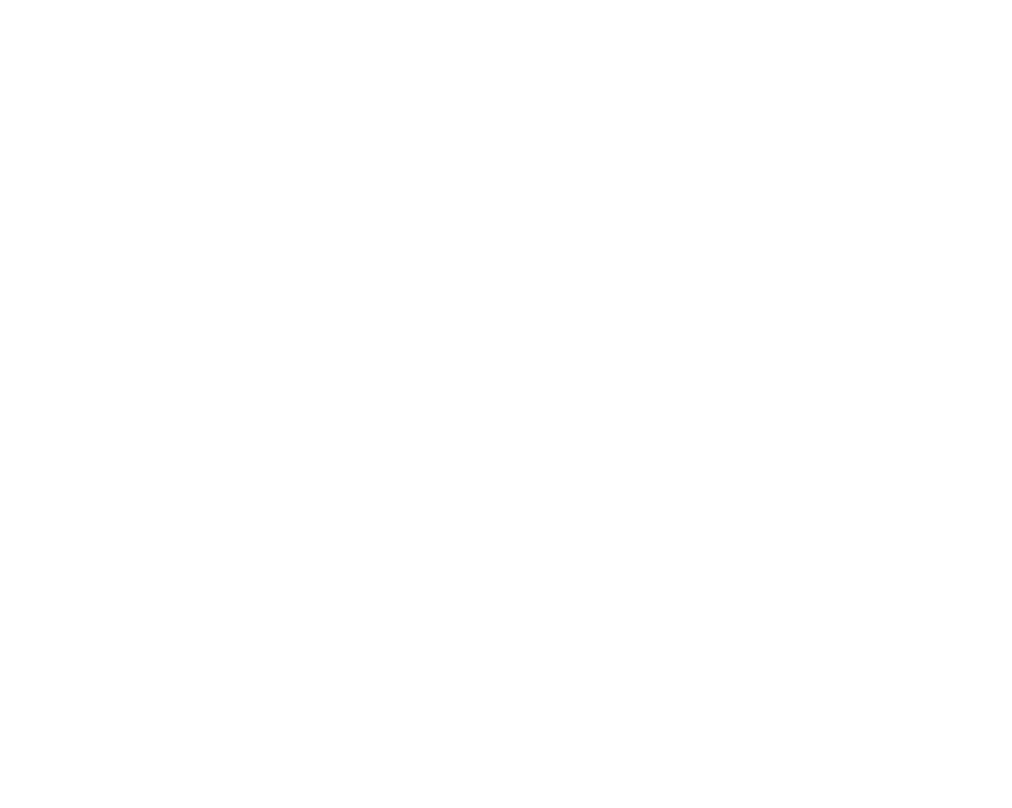
FNAC: fine needle aspiration